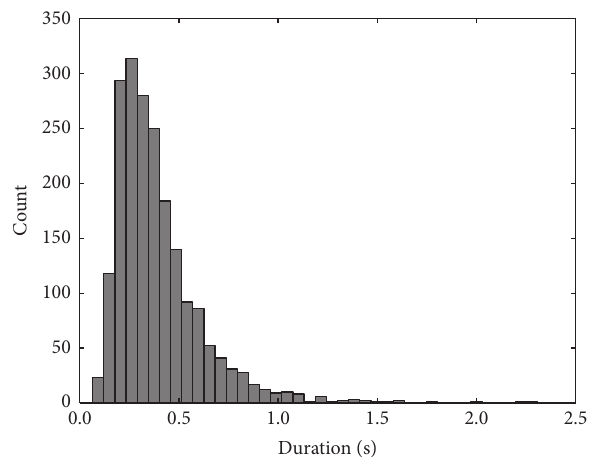
Figure 1: Distribution of hesitation duration over the joint corpus.